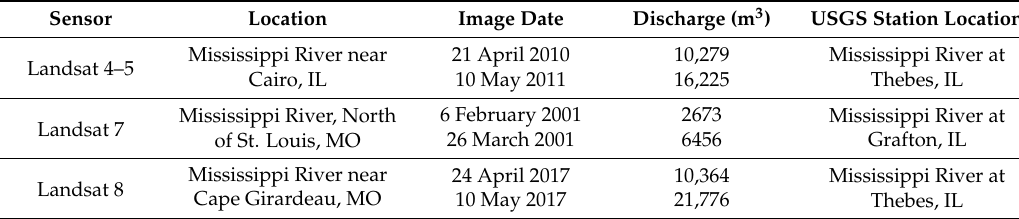
Table 5. Date and location information for the selected images used to generate SSC maps. Dates were chosen to highlight significant SSC events along the Missouri–Mississippi River system. Discharge levels represent the mean daily discharge and are reported using the nearest USGS monitoring location with available